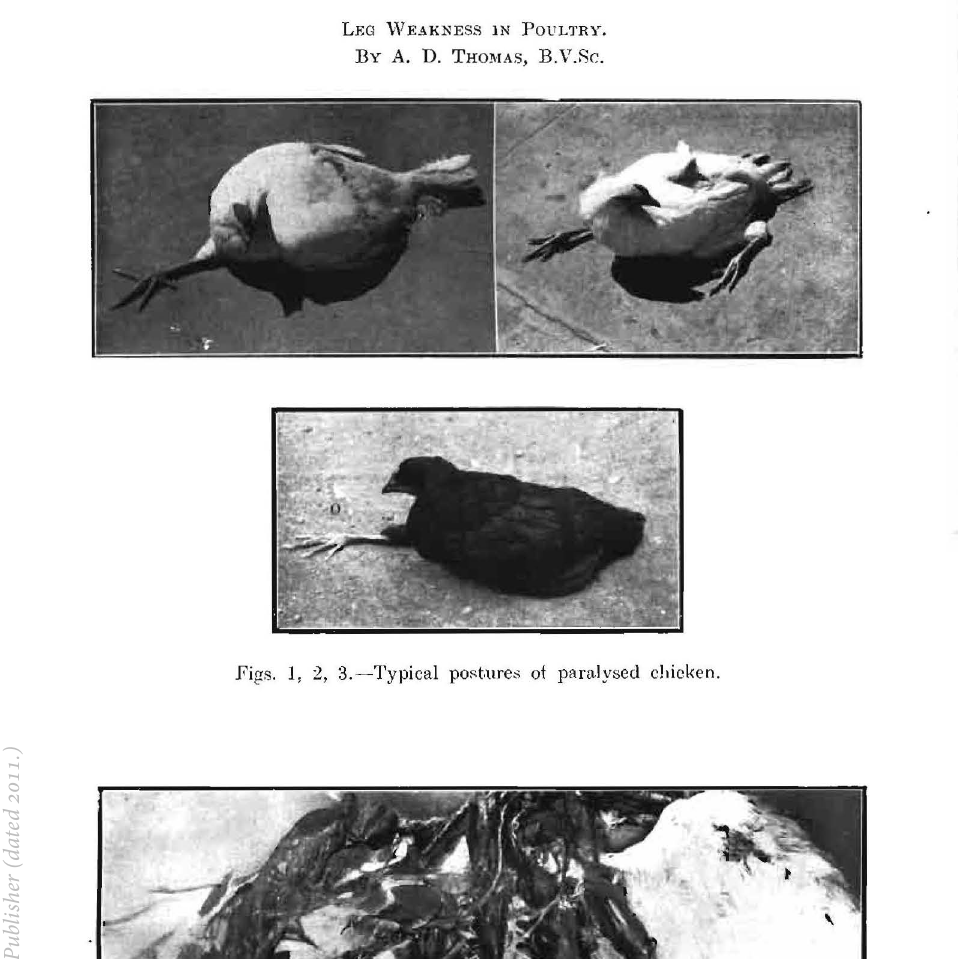
Fig8. 1, 2, 3.~Typical posture,; of paralysed chicken.